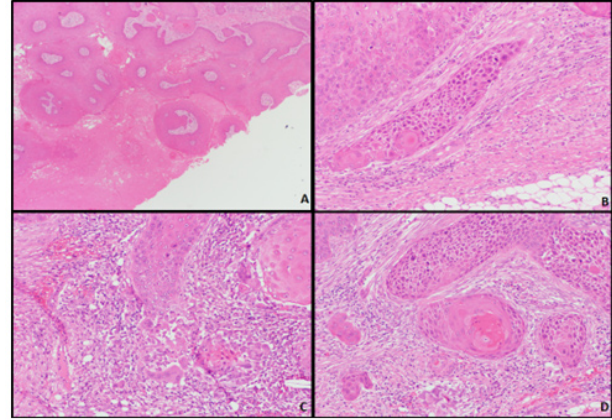
Figure 2. Microscopic images of the skin tumour. ( A ) Squamous epithelium with trichilemmal keratinisation (x4 objective). ( B – D ) Epithelium with nuclear pleomorphism, mitoses and an infiltrative architecture (x20